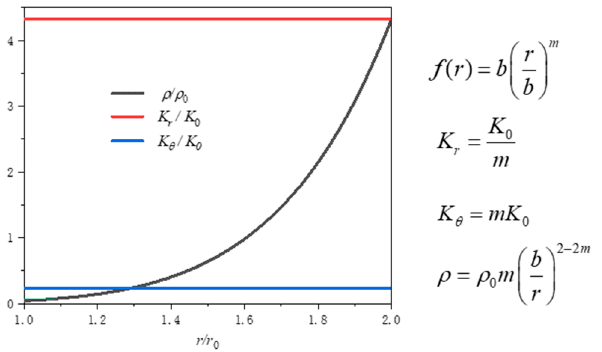
Figure 2. Constant modulus mapping material parameters distribution with radius and calculation formula.